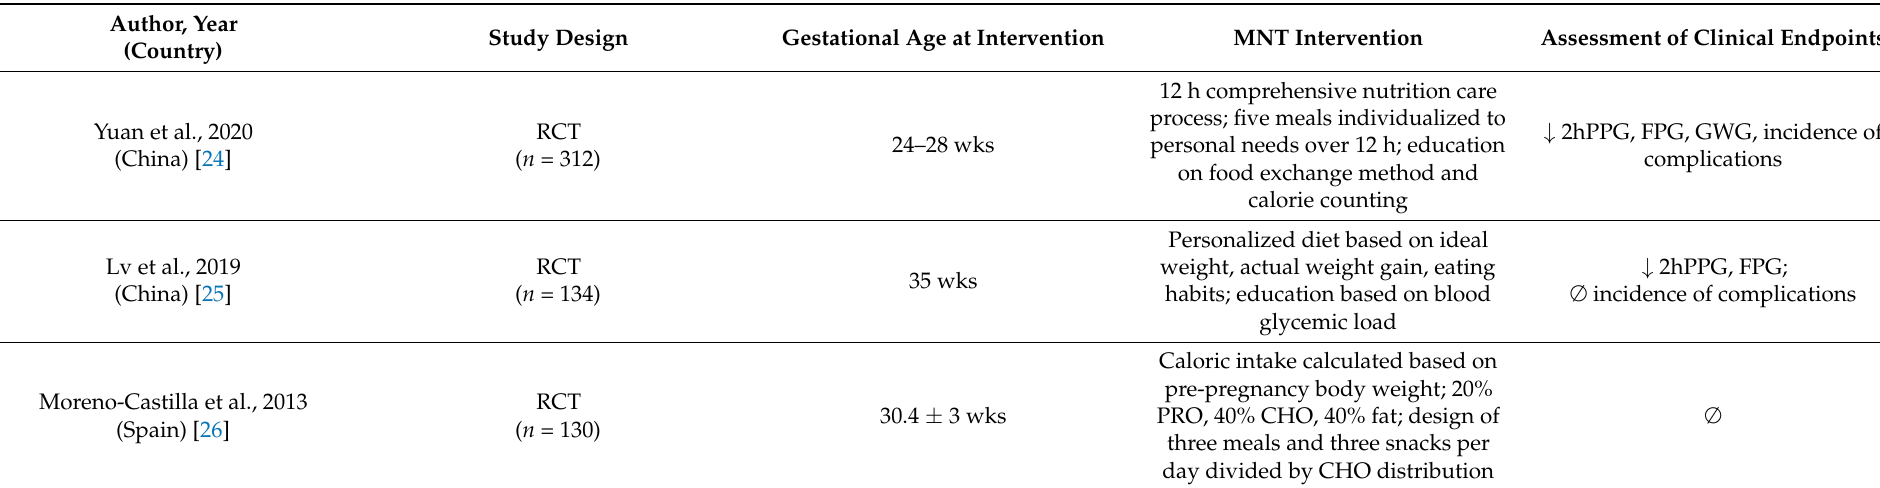
Table 2. Studies measuring the outcomes of medical nutrition therapy in women with gestational diabetes